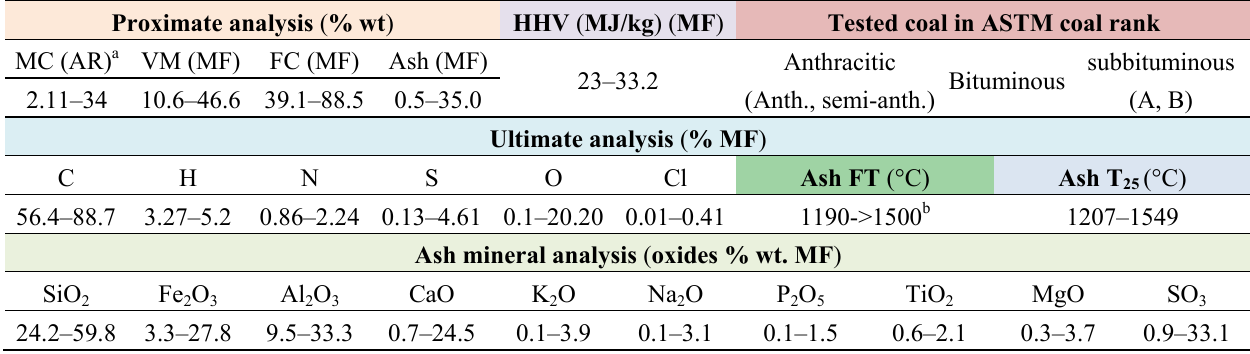
Table 2. Coal properties used in demonstration IGCC plants and coal rank [5,10,29]. Proximate analysis ( % wt